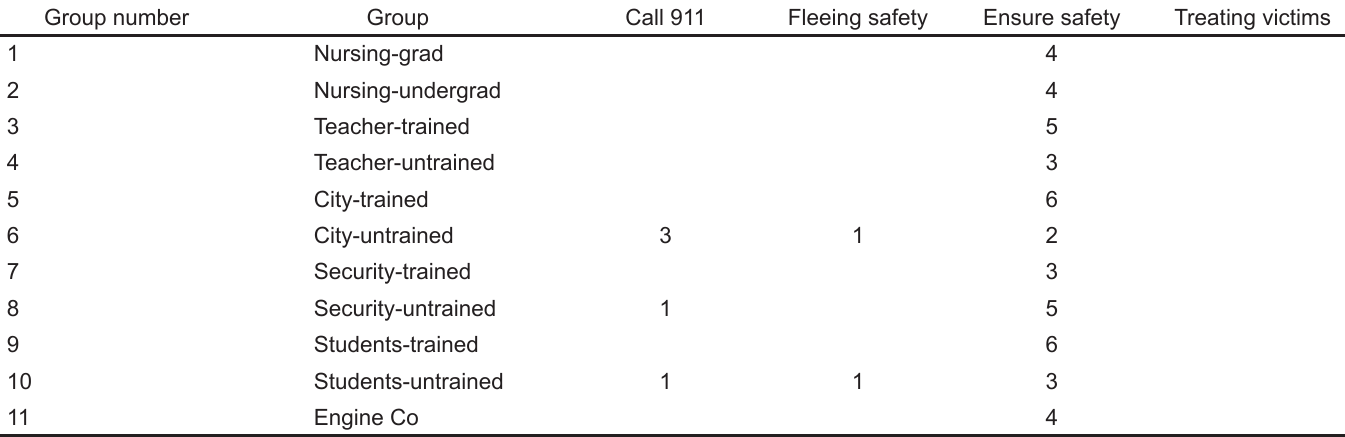
Table 3. Answers to Question 3 of the pre-test, organized by group number.